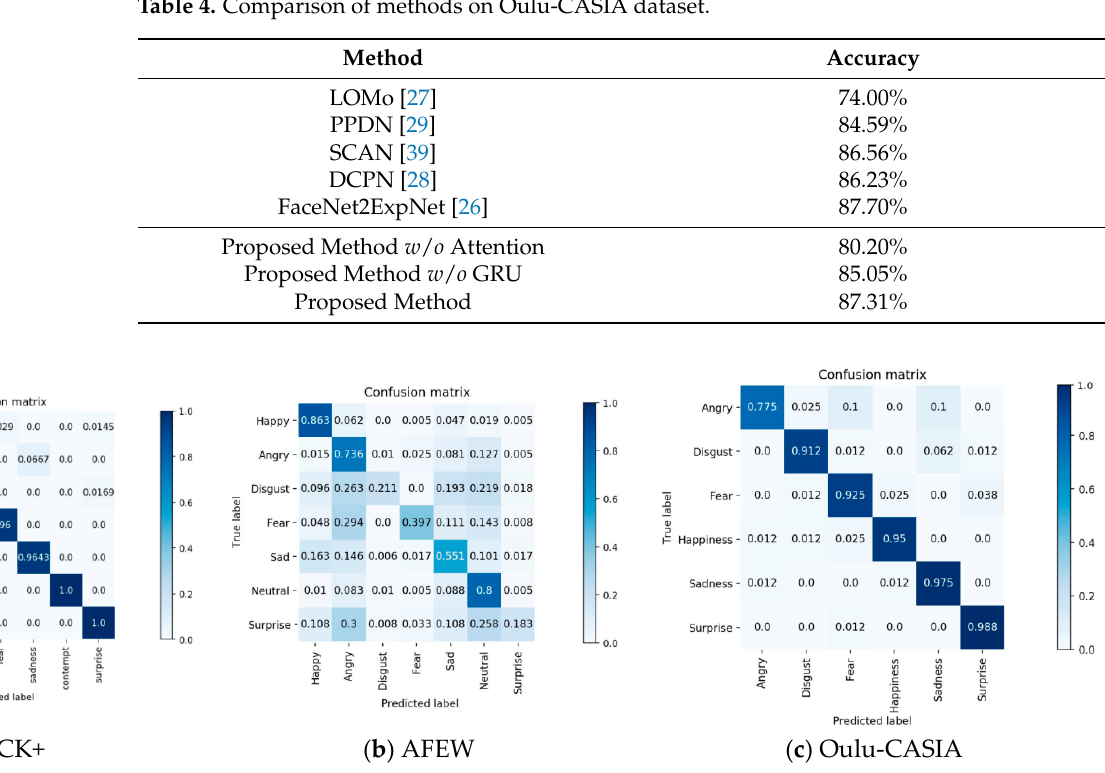
(c) Figure 8. Multiclass receiver operating characteristic (ROC) curves and their area under the ROC curve (AUC) areas on CK+, AFEW, and Oulu-CASIA datasets. In each subfigure, there are either nine or eight lines plotted with different colors, including (i) two lines that represent the macro-average ROC curve and the micro-average ROC curve of the dataset, and (ii) either seven or six lines that represent the corresponding ROC curve for each expression in the dataset. To be specific, in the subfigure ( a ) (i.e., CK+ dataset), classes 0–6 correspond to the expression s of Happy, Anger, Disgust, Fear, Sadness, Contempt, and Surprise, respectively; In subfigure ( b ) (i.e., AFEW dataset), classes 0–6 correspond to the expressions of Happy, Angry, Disgust, Fear, Sad, Neutral, and Surprise respectively; in the subfigure ( c ) (i.e., Oulu-CASIA dataset), clas- ses 0–5 correspond to the expressions of Anger, Disgust, Fear, Happiness, Sadness, and Surprise respectively. 5. Conclusions This paper has proposed a cascade network for FER comprising a spatial feature ex- traction module, a hybrid attention module, and a temporal feature extraction module. In the proposed method, the ResNet50 structure is used to extract spatial features, and the